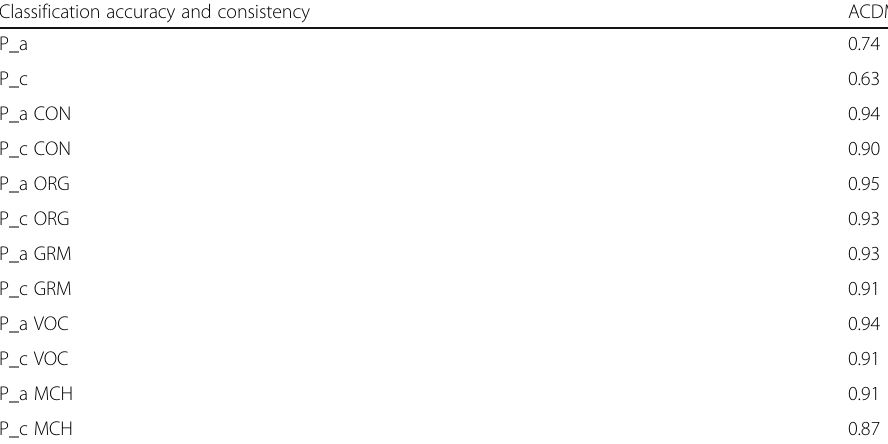
Table 3 Classification consistency P c and accuracy P